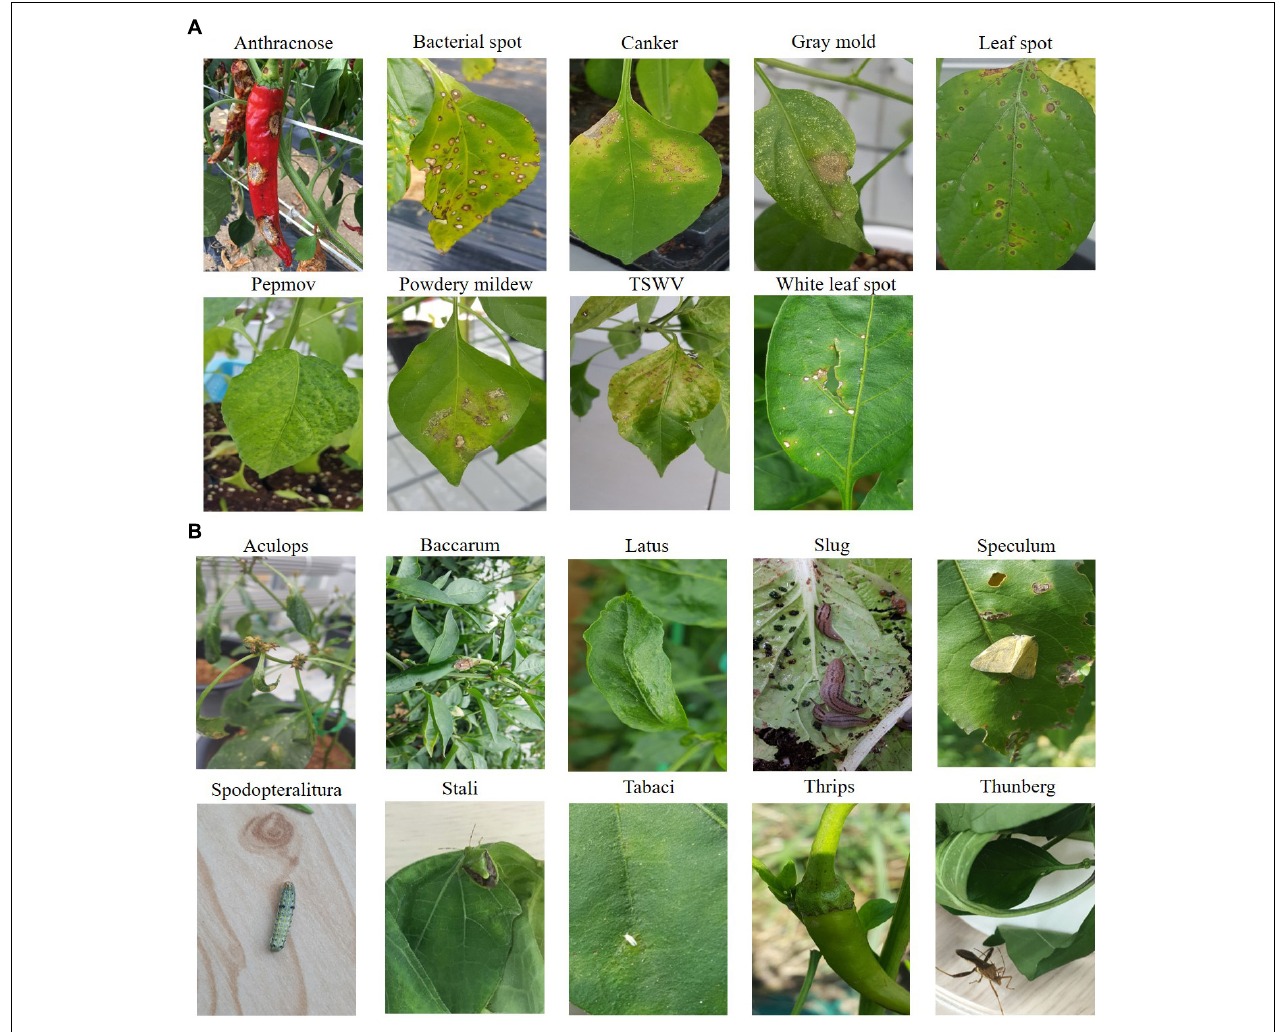
FIGURE 1 | Examples of disease/pest classes. TABLE 1 | Summary of hot pepper disease